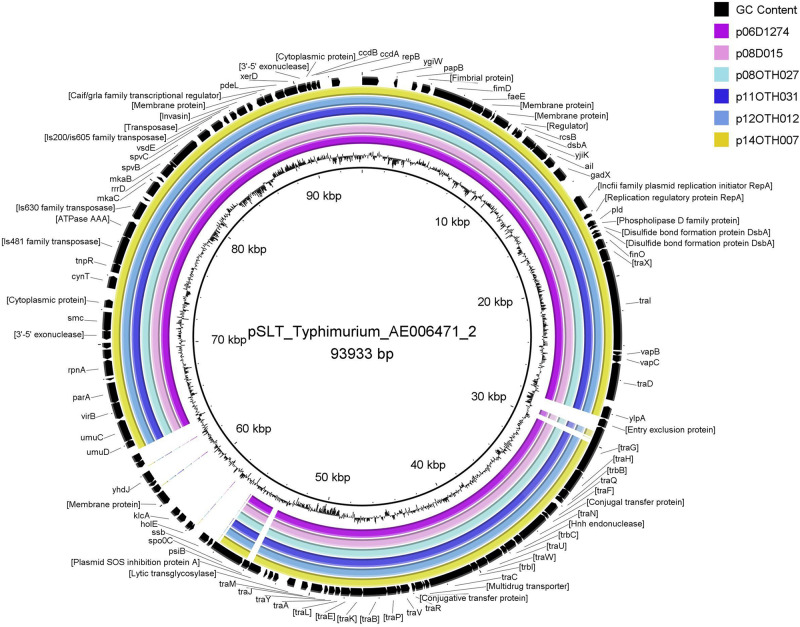
BRIG diagram comparing unusual S. Enteritidis plasmid sequences with that of the reference plasmid pSLT. Colored rings represent 100% similarity to the reference sequence.